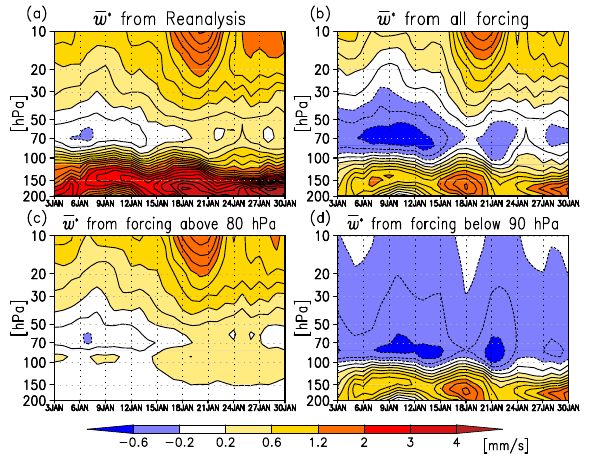
Fig. 4. Time series of residual mean vertical wind (mms − 1 ) in the tropics averaged over 50–20hPa, based on all forcings. (a) Ob- servations (black thick-solid line), forcing in the all regions (gray solid line), all regions including observed boundary values (red thin- solid line), global troposphere (green solid line), and global strato- sphere (blue solid line). (b) Forcing in the global stratosphere (blue solid line; same as Fig. 4a), northern hemispheric stratosphere (blue dashed line), and southern hemispheric stratosphere (blue dotted line). See Table 1 for